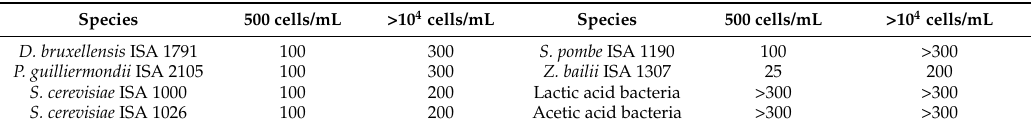
Table 1. Minimum lethal concentration of dimethyldicarbonate (DMDC) (mg/L) against several wine related microbial species as a function of initial cellular inoculum (adapted from